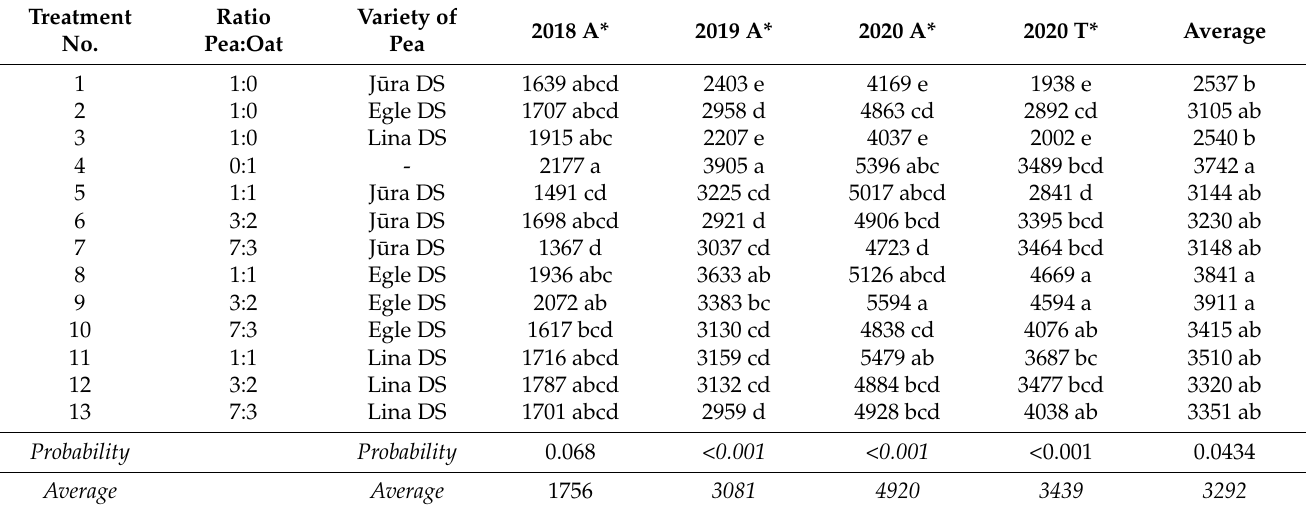
Table 4. The grain yield of crops during three years in four experiments, depending on the pea sowing rate and different cultivars.